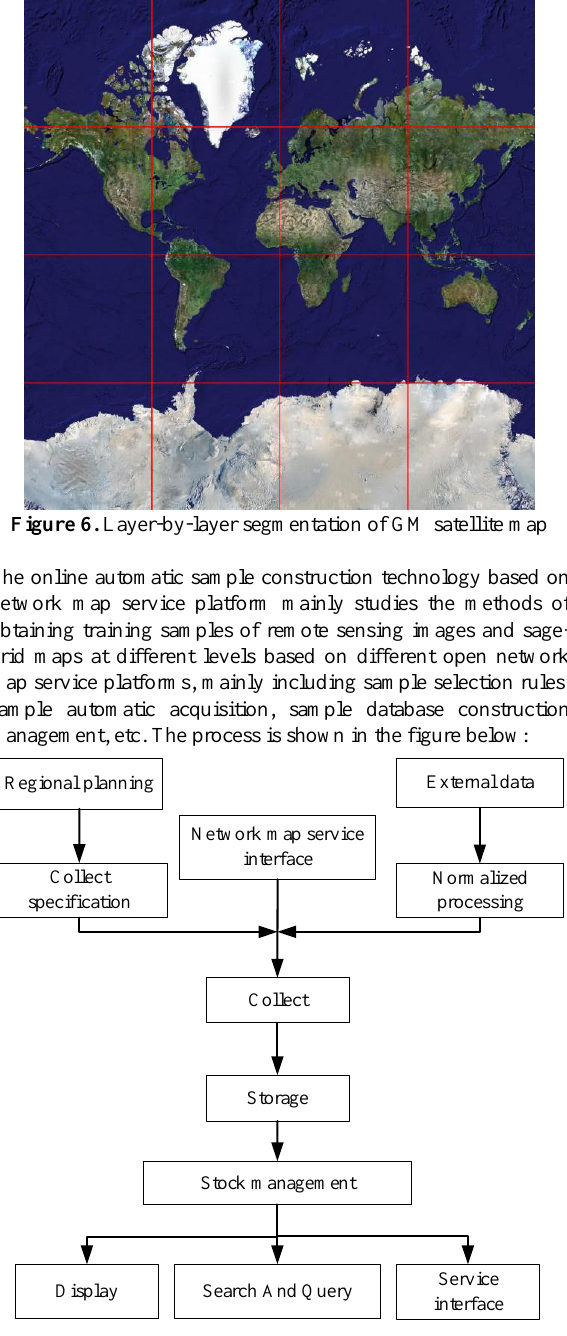
Figure 7. Technical approach to sample